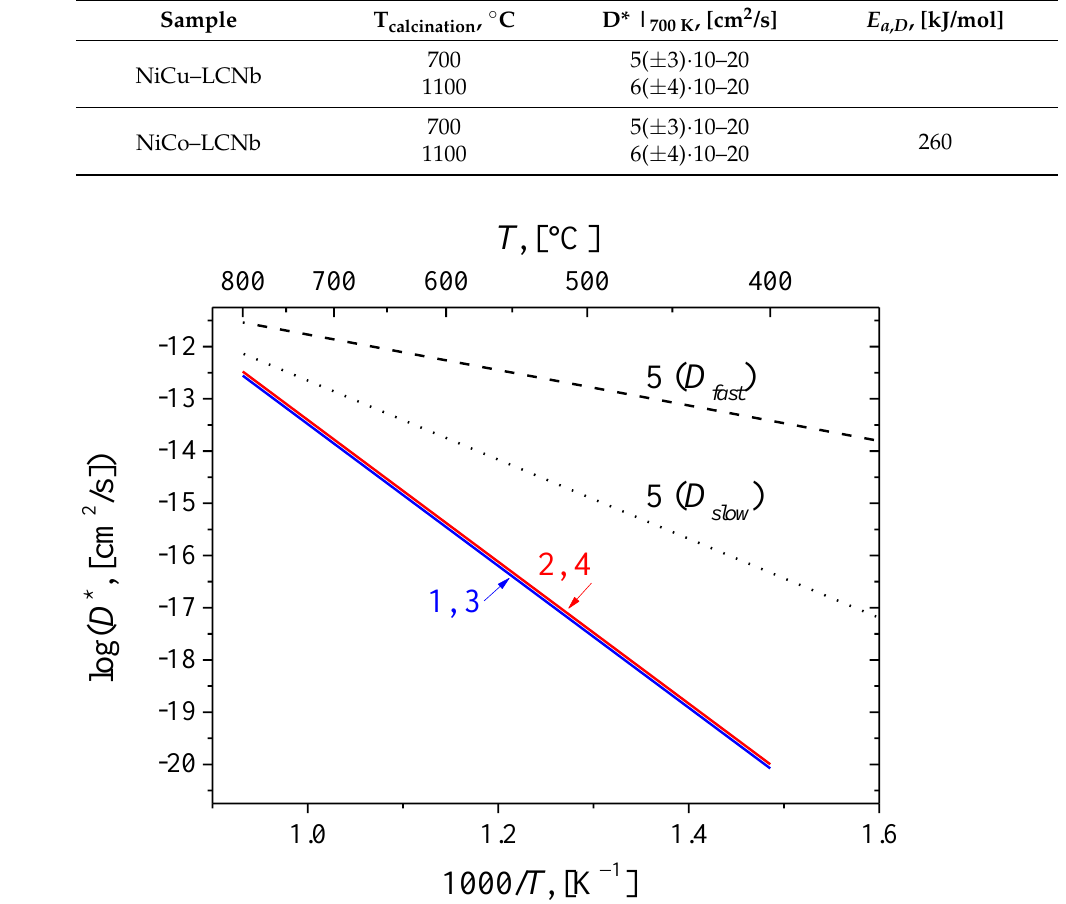
Figure 13. Arrhenius plots of tracer diffusion coefficient for NiCu – LCNb (1, 2) and NiCo – LCNb (3, 4) samples sintered at 700 °C (1,3) and 1100 °C (2,4) compared with LCNb sample (5) [4], according to TPIE with C 18 O 2 data modelling.